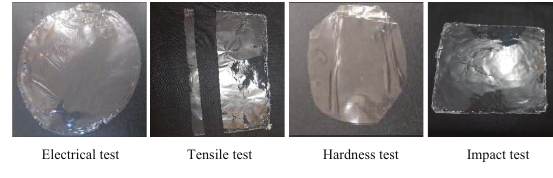
Figure 1: The sample micrographs required for each test.